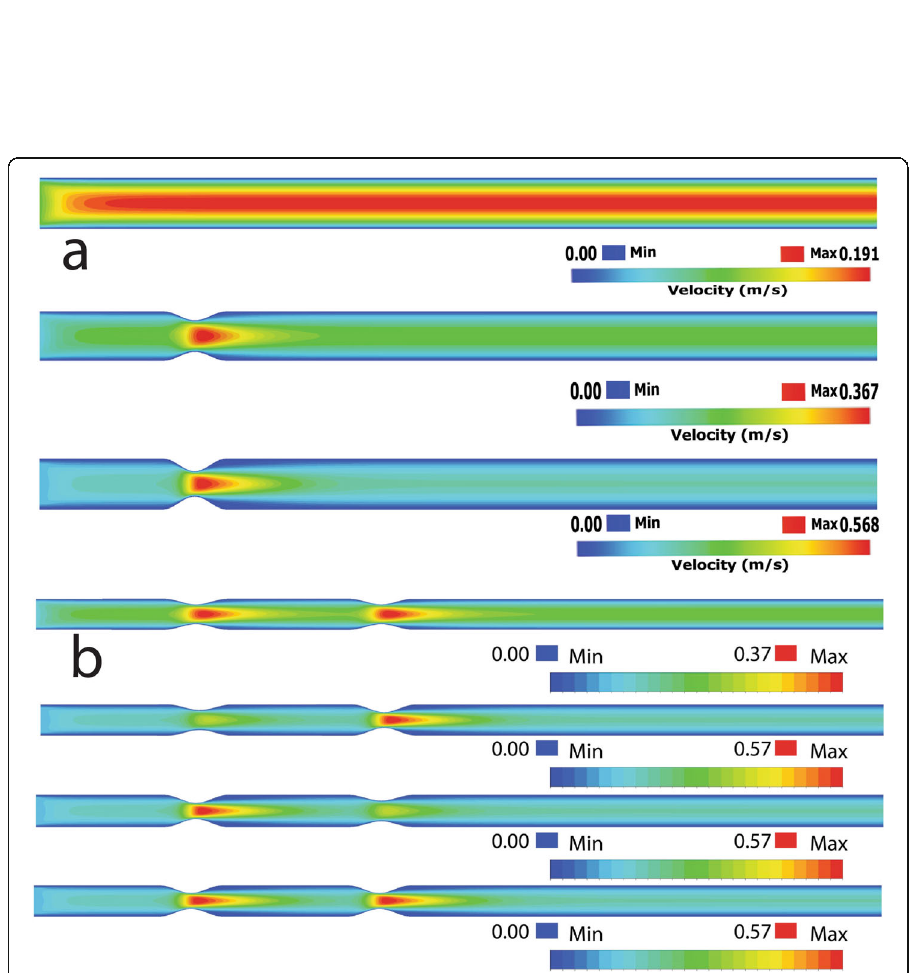
Fig. 4 a Velocity contour for single stenosis along XY plane, and b velocity contour for multiple stenoses along XY